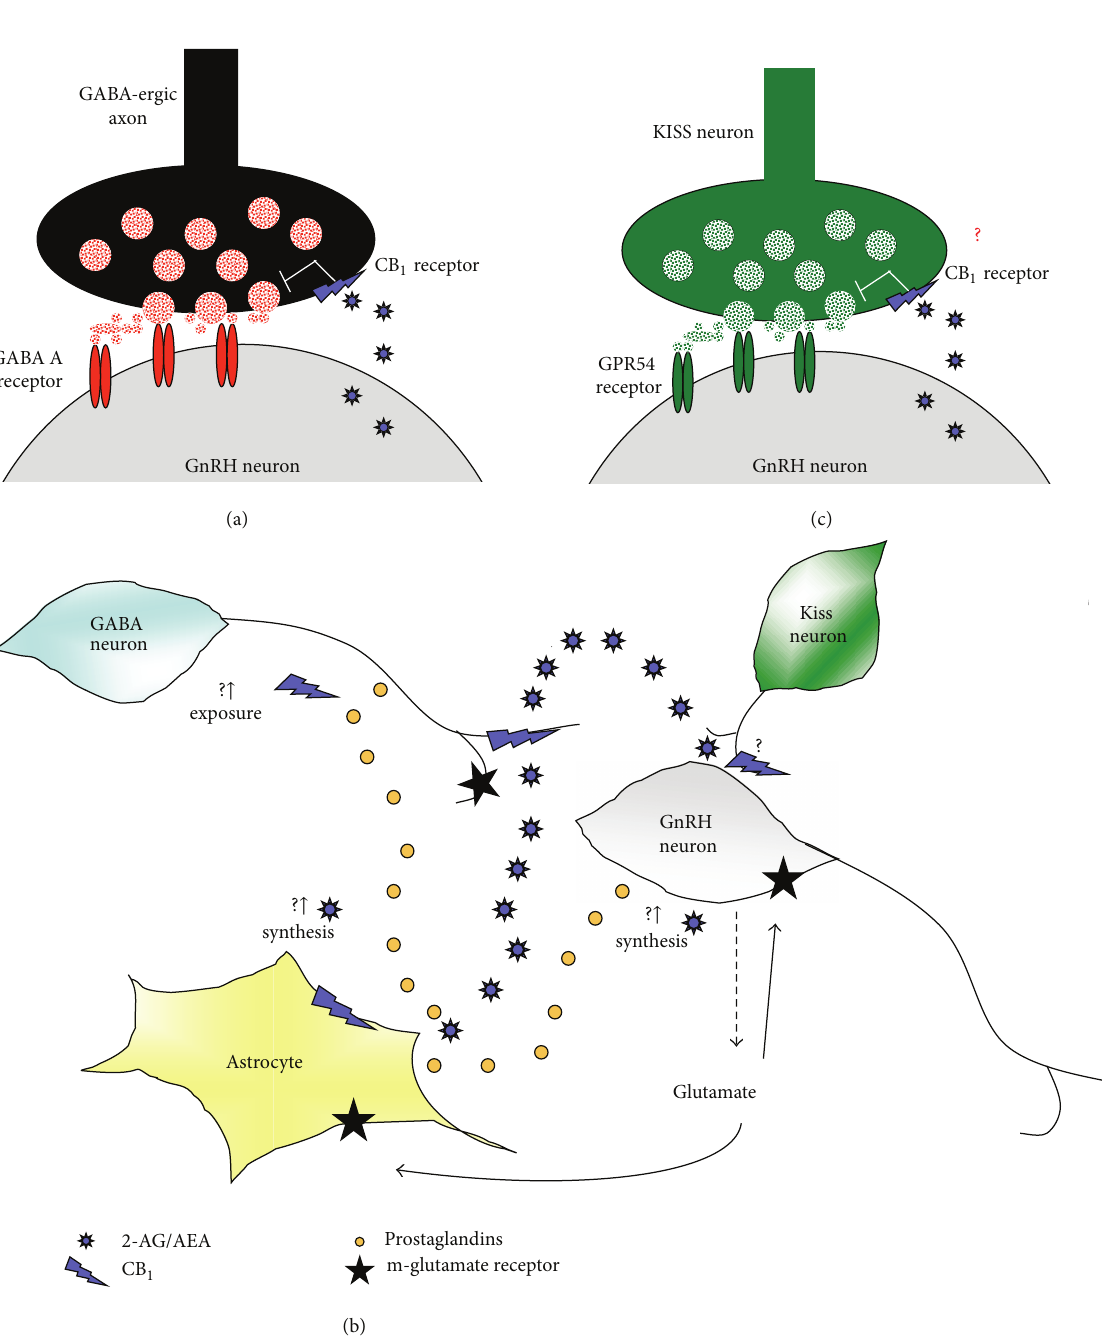
Figure 3: Possible mechanisms for the modulation of GnRH secreting neurons by eCBs. (a) GABAergic modulation of GnRH secreting neurons. GnRH secreting neurons release eCBs that, as retrograde signals, directly act on CB 1 located on GABAergic presynaptic neurons and inhibit the release of GABA; as a consequence, GnRH secreting neurons do not receive GABAergic input and do not release the GnRH. (b) Possible involvement of glial cells in eCBs/GABA/GnRH circuitry. Glutamate release by GnRH neurons may stimulate astrocytes to produce prostaglandins which in turn induce the synthesis of eCBs and/or the exposure of presynaptic CB 1 , thus modulating GABA release. (c) Hypothesis: are there neuronal systems other than GABAergic able to modulate endocannabinoid/GnRH crosstalk? Kisspeptins stimulate gonadotropin discharge in several species modulating the activity of GnRH secreting neurons via the activation of GPR54 receptor located on GnRH neurons. Might AEA also act as retrograde signal upon kisspeptin neurons in order to suppress GnRH